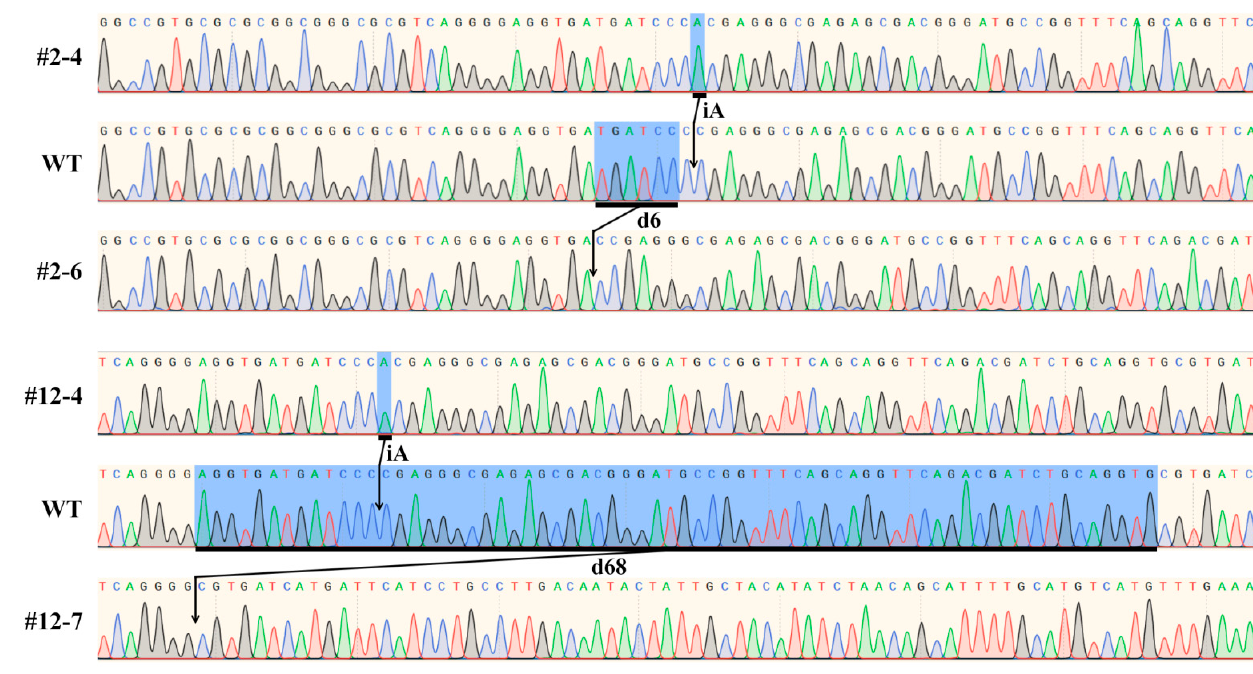
Figure 3. Sequencing analysis of homozygous offspring plant of #4 and 6 in bi-allelic mutant line of #2 (Figure 2C) and #4 and 7 in bi-allelic mutant line of #12 (Figure 2D). The mutation SBEIIb target sequences of offspring plants in the bi-allelic mutant line of #12 (Figure 2D) were also amplified using routine PCR primers and system. The homo- zygous mutation plants with an insertion of A and deletion of 68 nucleotides all exhibited one band with large molecular weight for the former and small molecular weight for the latter in the agarose gel, and the bi-allelic mutation plants had two bands (Figure 4). The genotypes of offspring plants in bi-allelic mutant line of #12 detected by routine PCR agreed with those detected by AS-PCR (Figures 2D and 4), indicating that the offspring genotypes of bi-allelic mutant lines could be detected accurately by AS-PCR method. Figure 4. Genotype detection of offspring plants of iA/d68 T1 line using routine PCR. M, DNA marker; Kit, wild type rice Kitaake; and 1–21, the same plants of T2 segregation population detected in Figure 2D.